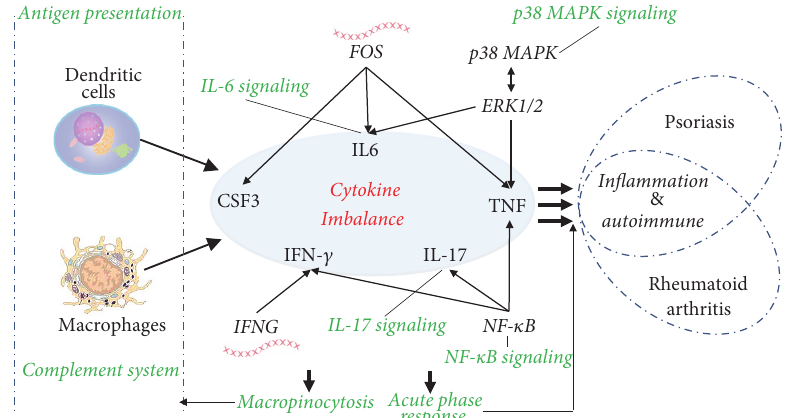
Figure 7: The common molecular mechanisms of PS and RA are characterized by a cytokine imbalance. Arrows represent the relationship between molecules or between molecules and cells. Green terms represent signaling pathways. The molecules in ovals are cytokines.